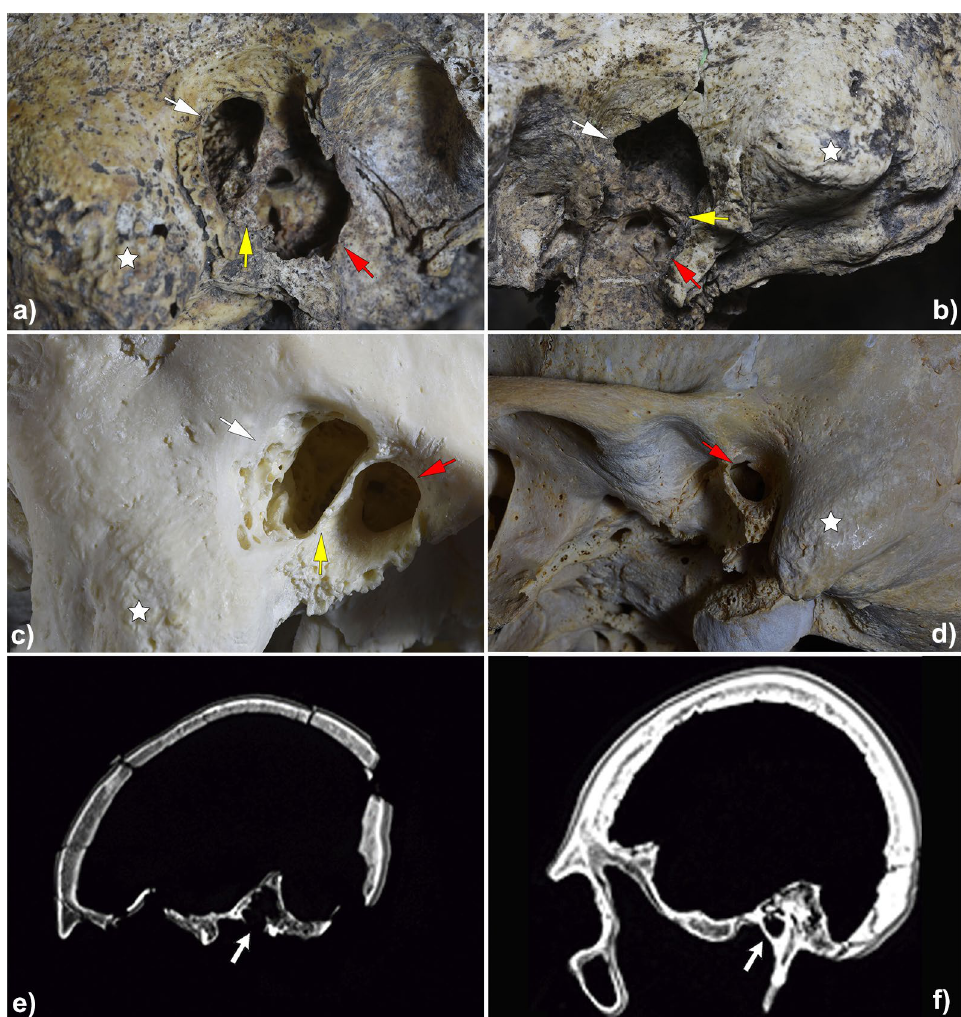
Figure 4. Computed tomography scans and details of both temporal bones of the skull under study and some samples of the comparative analysis. Superior: Details of external auditory region on the right ( a ) and the left ( b ) temporal bones of the skull under study. It is to be noted the deterioration of the tympanic cavity in both temporal bones due to taphonomic processes. Middle: Present-day skull with mastoidectomy performed by the students of the Faculty of Medicine of the University of Valladolid ( c ) and example of an archaeological skull without any pathology used for comparative analysis ( d ). Red arrows indicate the external auditory canal. White arrows point to bone erosion in the postero-superior part of the external auditory canal due to the mastoidectomy. Yellow arrows indicate the scutum —thin bony spur that is formed by the superior wall of the external auditory canal and the lateral wall of the tympanic cavity. *Mastoid process. Inferior: Computed tomography (CT) scans of para-sagittal sections at right middle ear level—the arrows point to the middle ear— from the skull under study ( e ) and from a present-day skull without pathology ( f